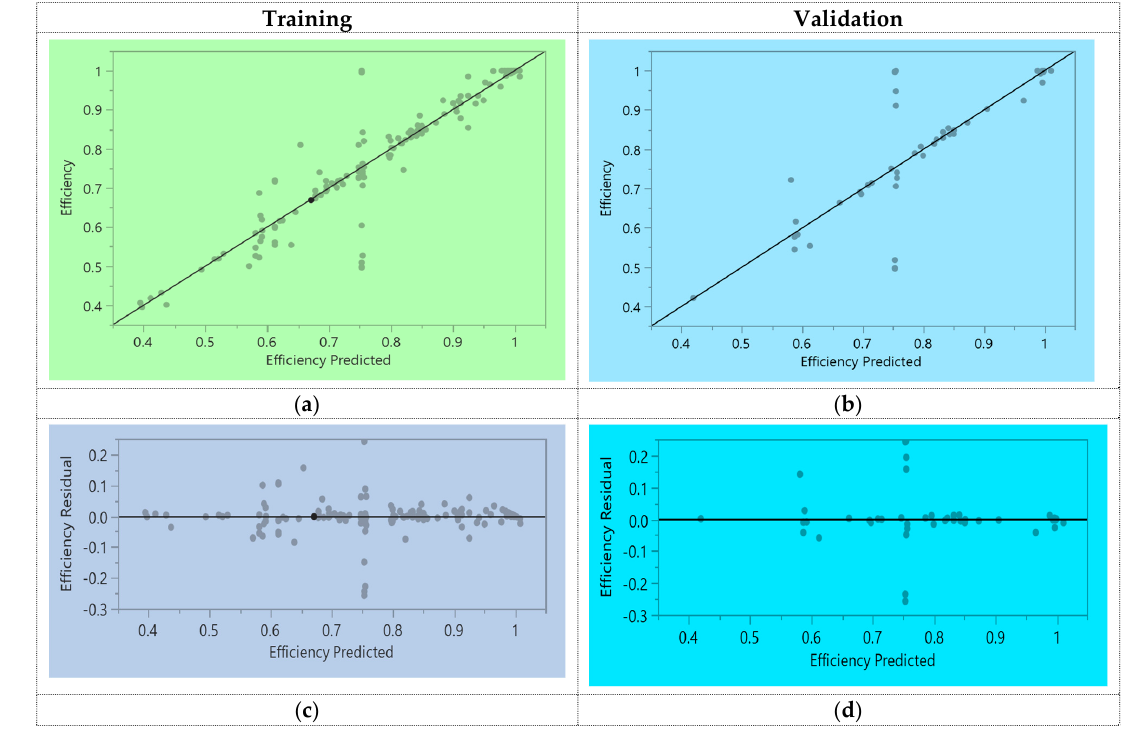
Figure 5. Training and testing plot for efficiency of GFRP-based RC columns .